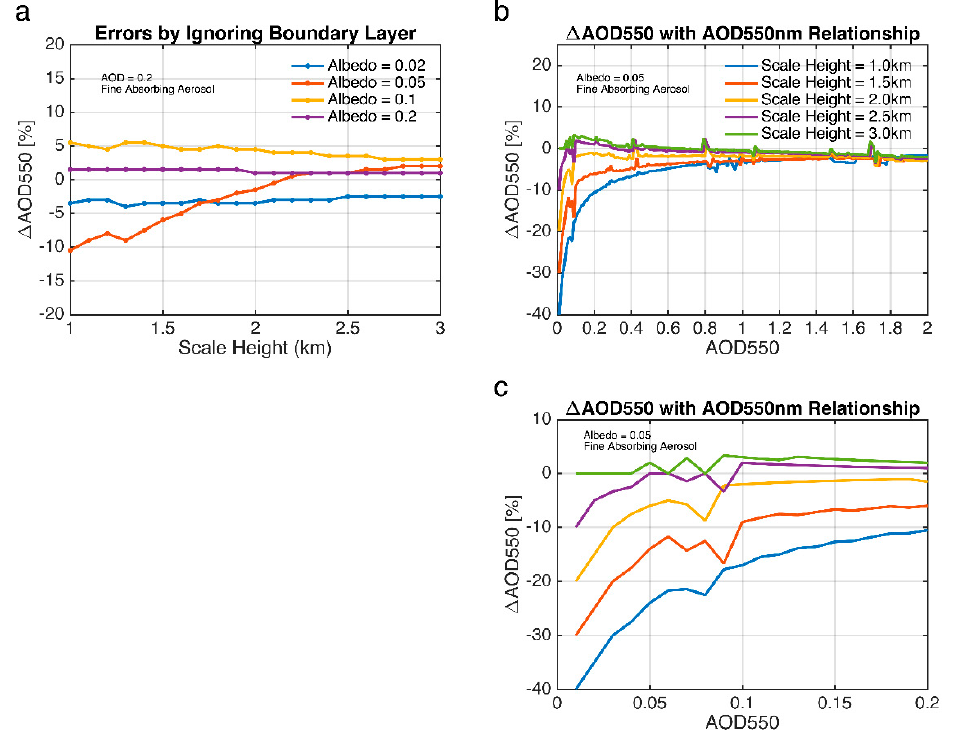
surface albedos (0.02, 0.05, 0.1, 0.2). ( b ) The change in AOD relative errors with the AOD value. The fine